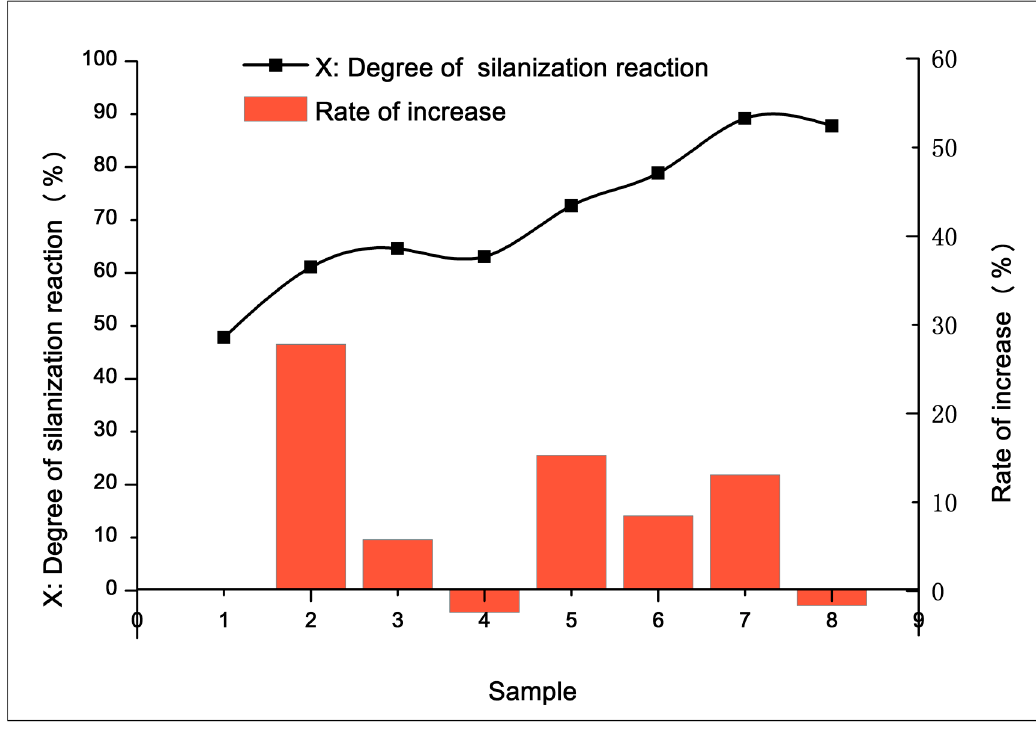
Figure 10. Result of silanization reaction degree measurements.